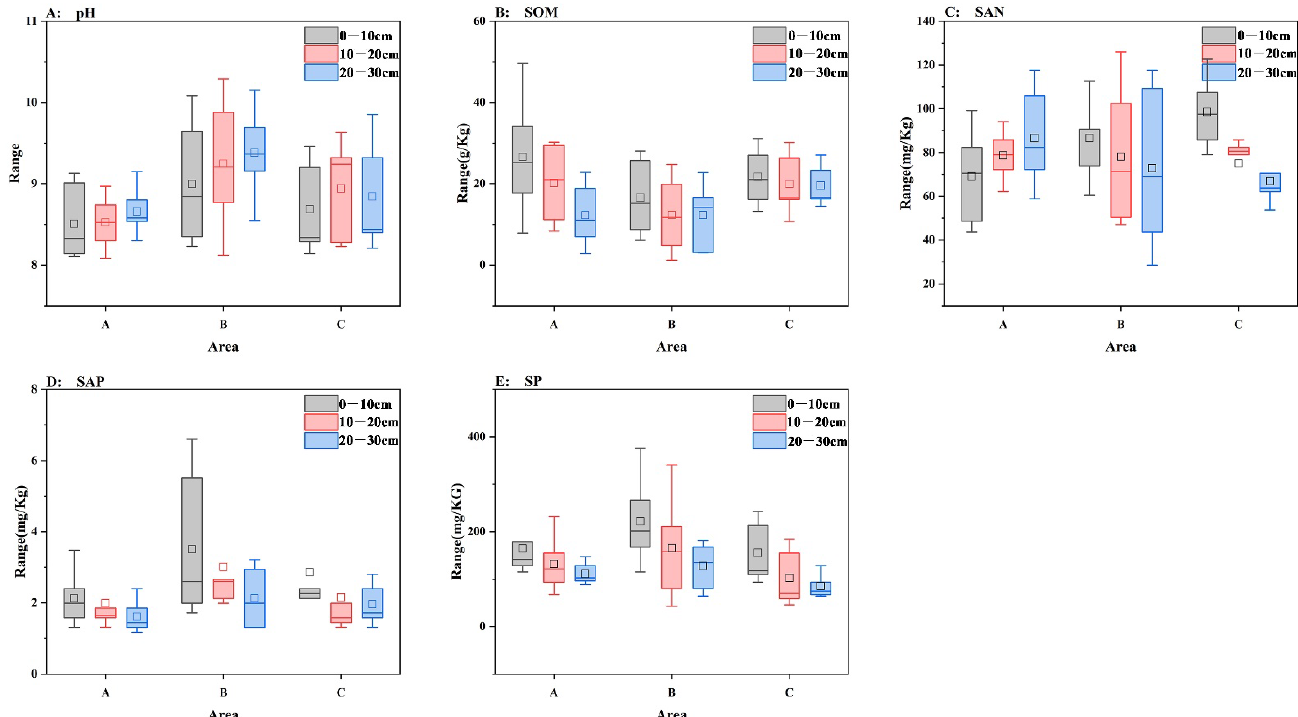
Figure 2. A descriptive diagram of the physical and chemical properties of the soil. The soil in all three areas was weakly alkaline, with mean pH values greater than 8.50. Area A exhibited the lowest average pH due to differences in coal quality and trans- portation issues. Area B was only affected by the soil parent materials and large variations occurred in areas up to a pH of 9.2, which may be explained as the result of the mining